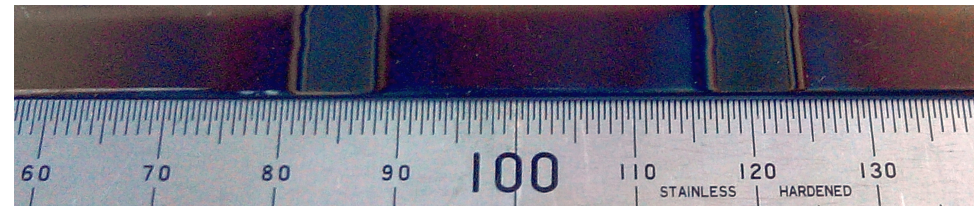
Figure 1. Representative diamond-like carbon (DLC) coatings on stainless